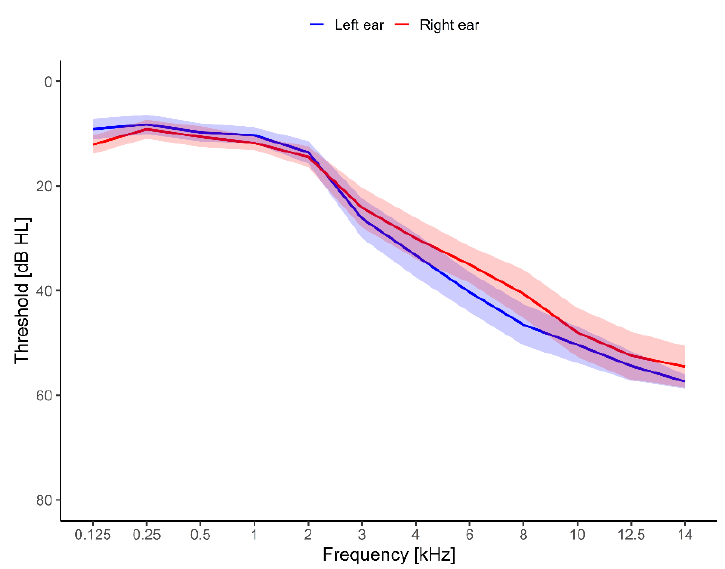
Figure 2. Hearing thresholds were measured from 125 Hz to 14 kHz. Results were averaged over each ear and shown with mean ± SEM. The red line is the average threshold for the right ear, while the blue line is the average threshold for the left ear.